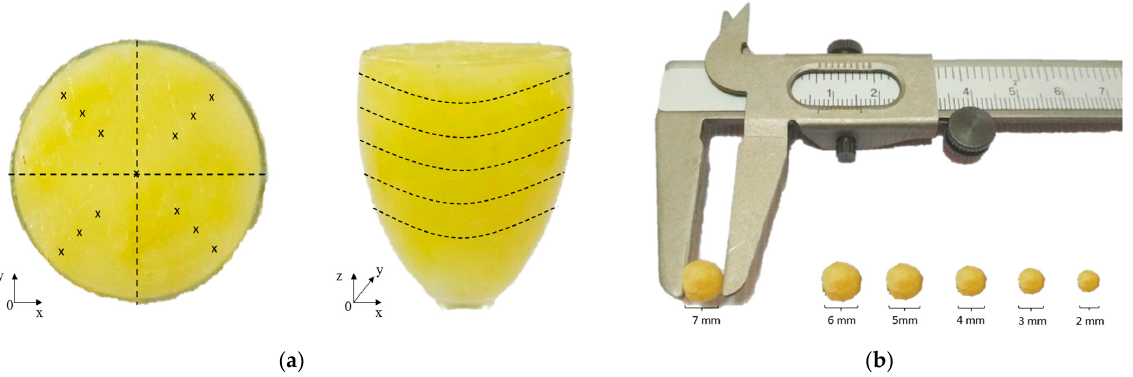
Figure 2. ( a ) The breast phantom; ( b ) The tumor. Figure shows the developed breast phantom and tumor for the